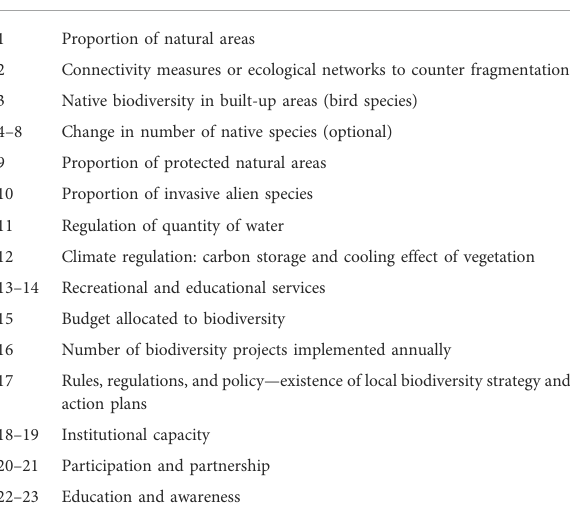
TABLE 1 List of indicators used in the computation of the City Biodiversity Index.